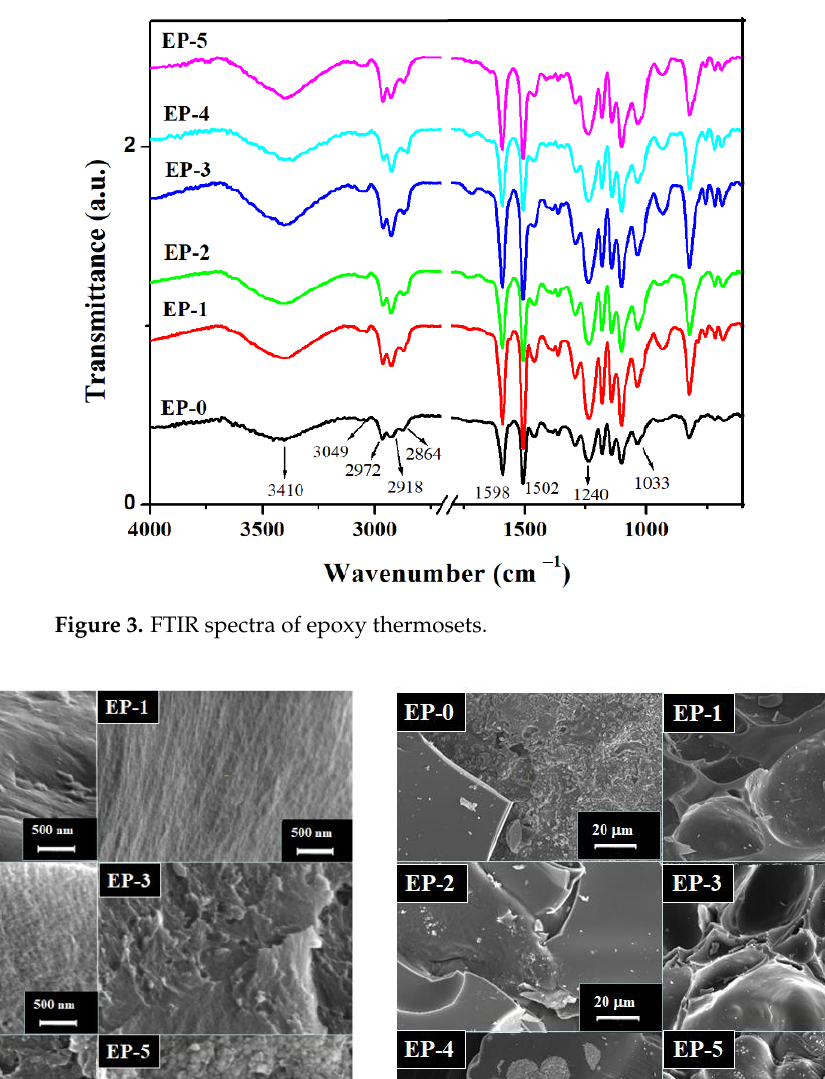
Figure 3. FTIR spectra of epoxy thermosets.